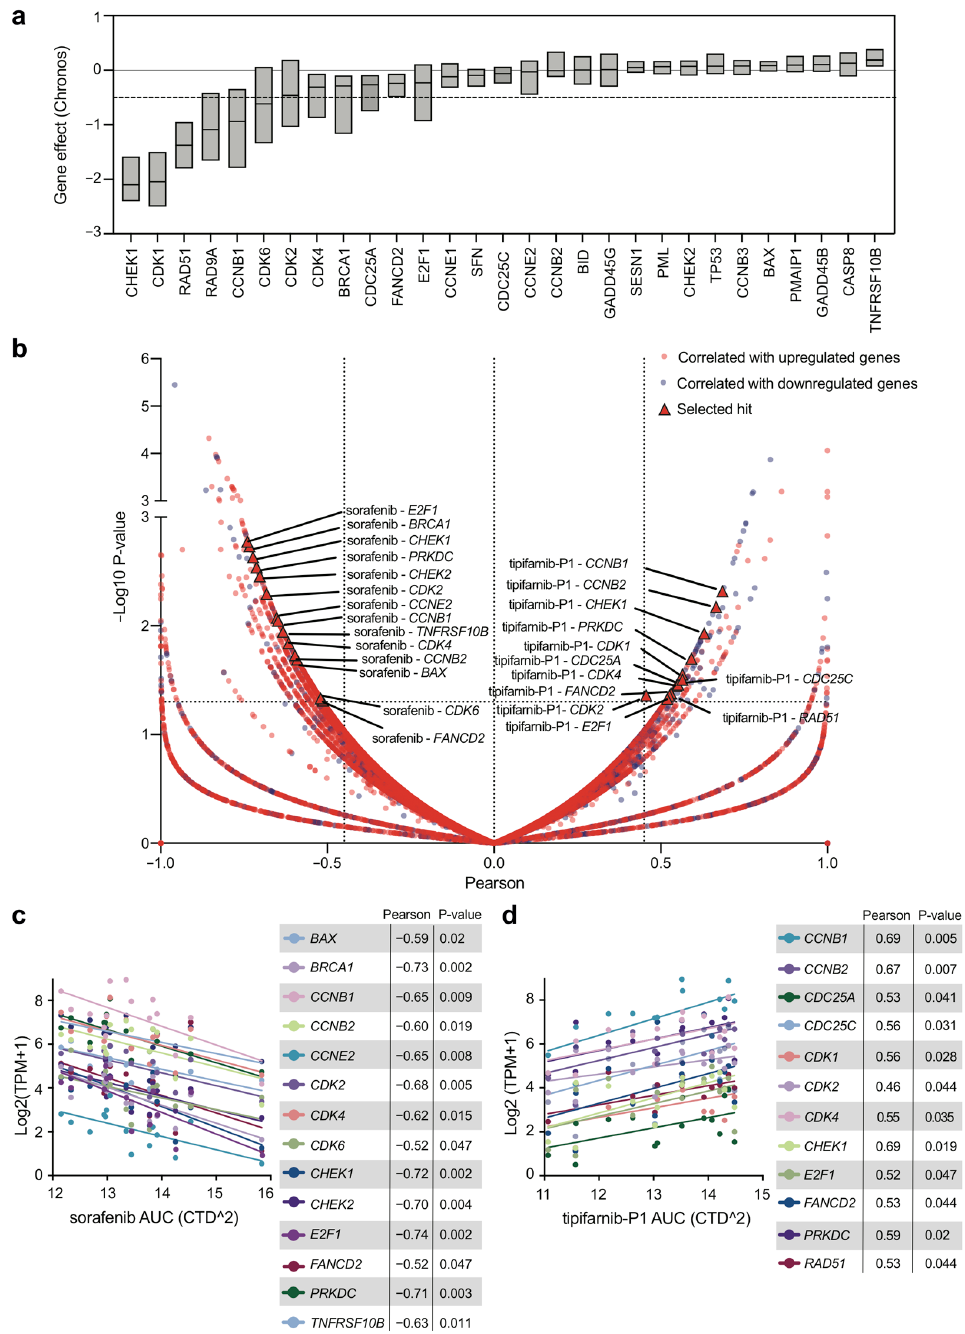
Figure 5. DDR genes perturbation effect and correlation with drug treatment on OSCC tumor cell lines. ( a ) Dependency analysis of DDR genes on OSCC cell lines using CRISPR data from DepMap databases (DepMap22Q2 Public + score, Chronos). The full line settled at 0 indicates no dependency. The dashed line settled at − 0.5 indicates survival dependency. ( b ) Volcano plot showing the correlation between DDR gene expressions and drug response in OSCC cell lines from drug sensitivity AUC (CTD ^2). The red dots depict the correlation between upregulated genes and drug response, while the blue dots represent the correlation between downregulated DDR genes and drug response. ( c , d ) Pearson correlation analysis between gene expression of the selected DDR genes and drug response to ( c ) sorafenib and ( d ) tipifarnib-P1 from DepMap databases. AUC, area under the curve; TPM, transcript per kilobase million.